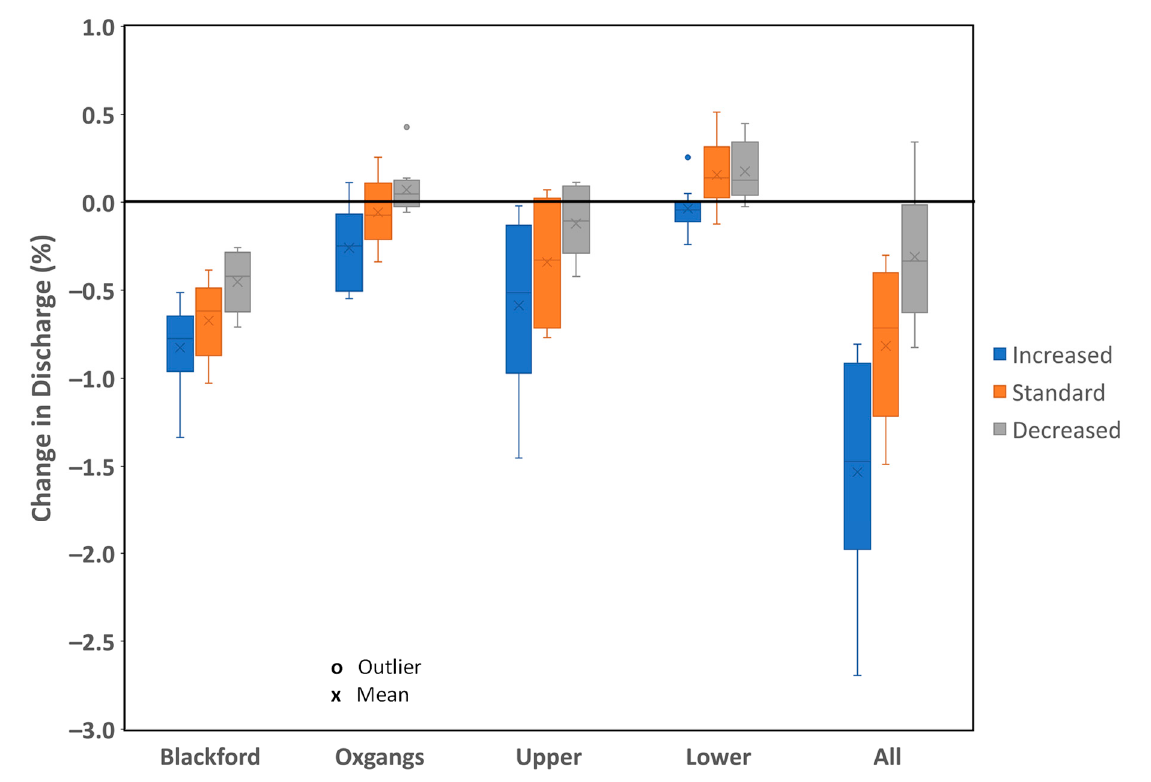
Figure 9. Box plot showing the change in the outlet discharge for each pond for the 10 rainfall events (8 annual maximum events and 2 design events). Additionally shown are the synergistic results for the catchment outlet due to incorporating all the ponds into the model. Results from the increased, standard and decreased storage are shown.